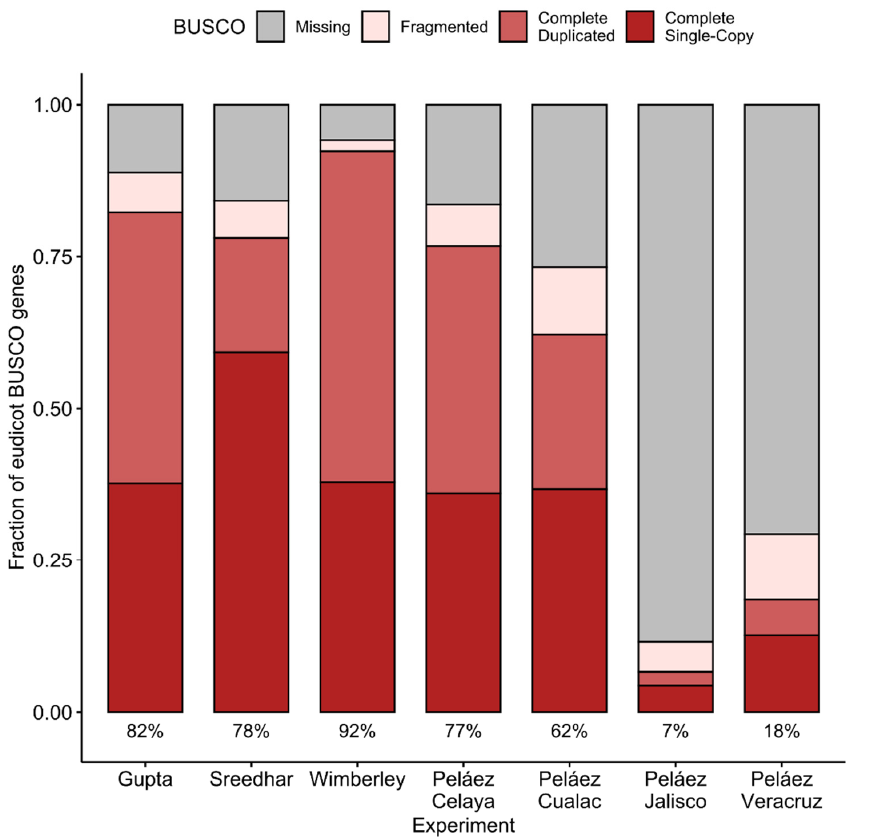
Figure 2. BUSCO assesses whether or not single-copy orthologs are represented in an assembled transcript sequence set (“completeness”) and whether or not they are present in multiple copies (“redundancy”). The first five bars illustrate a high completeness (red plus grey: Percentages shown below bar) but also considerable redundancy (grey bar) within the TrimGalore assemblies; the last four bars illustrate the heterogeneity among the four cultivars in the Pel á ez